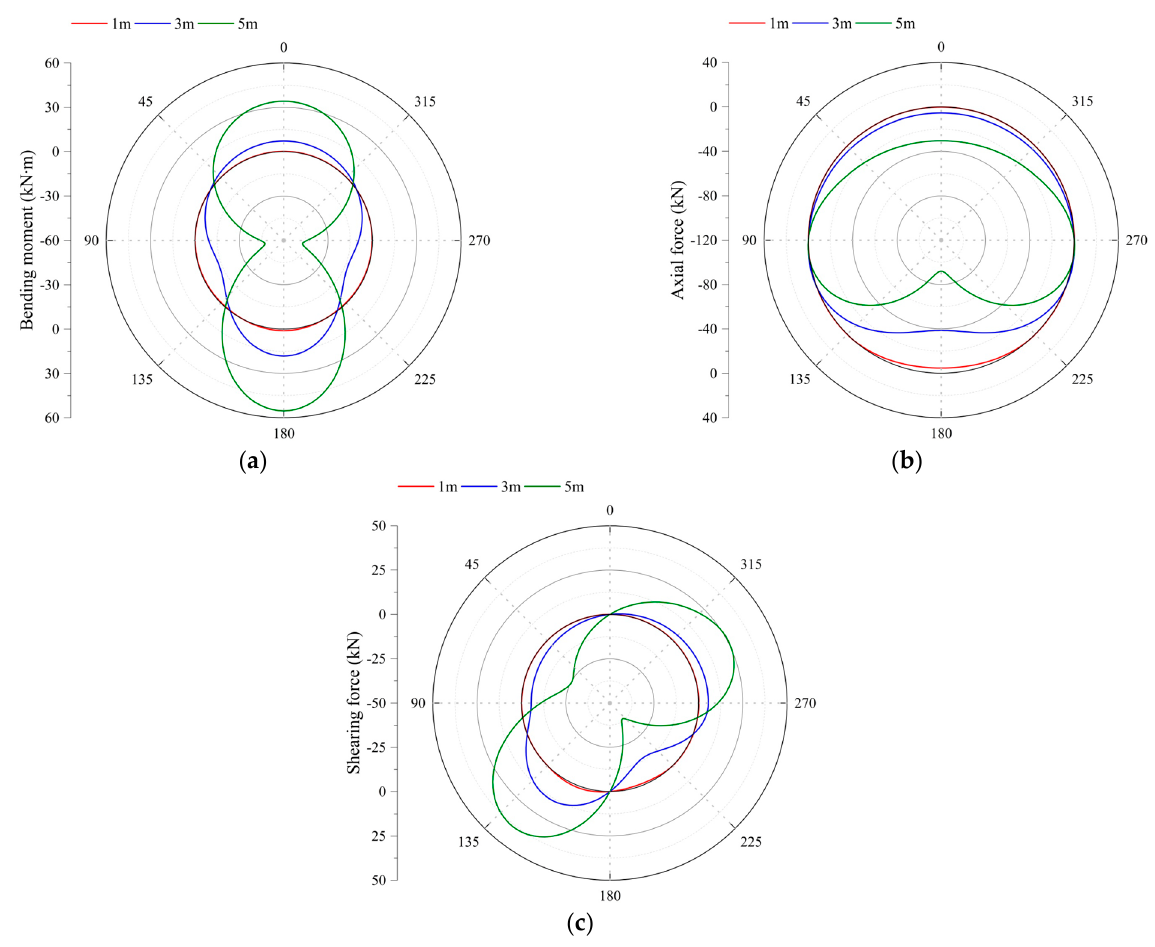
Figure 10. Influence of water conveyance level without pressure on internal force distribution of lining. ( a ) Bending moment distribution diagram. ( b ) Axial force distribution diagram. ( c ) Shear force distribution diagram.